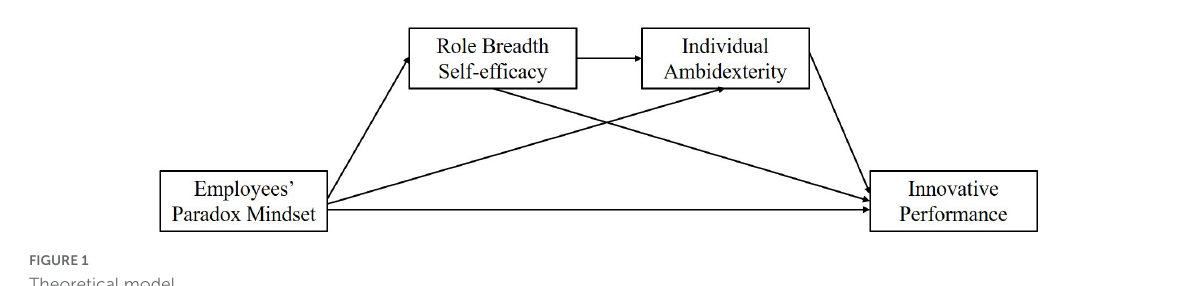
FIGURE1 Theoretical